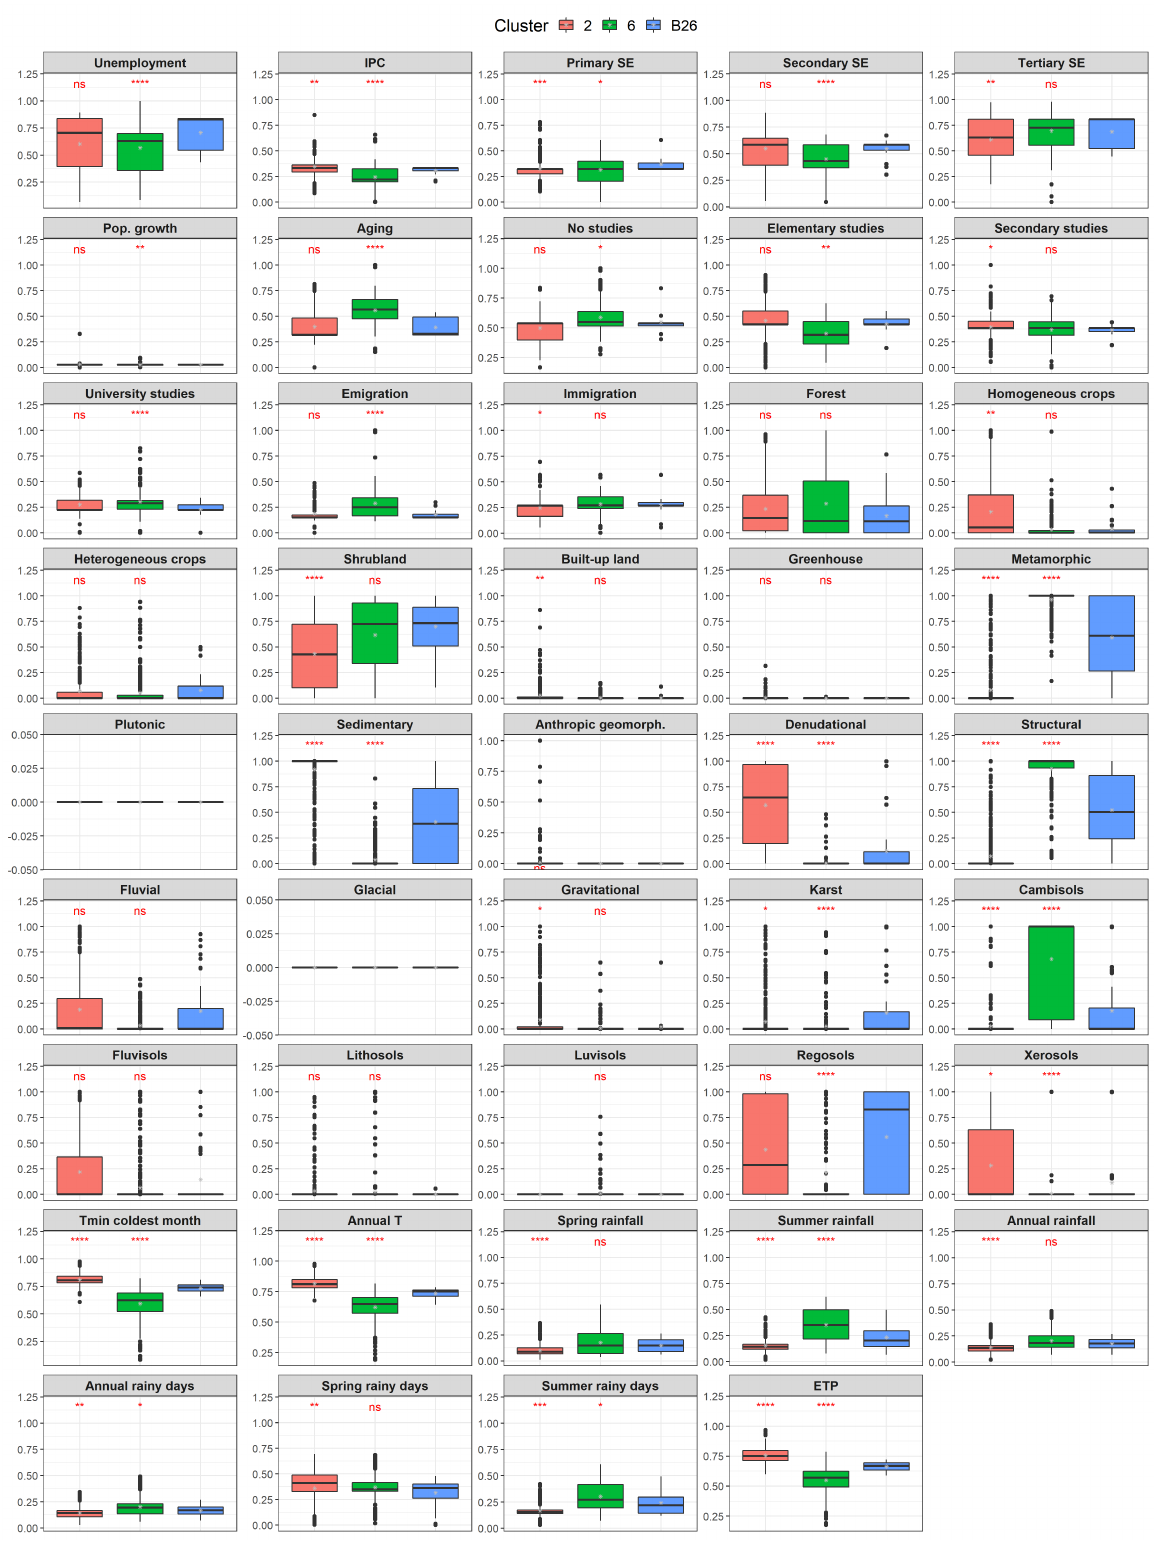
Figure A4. Comparison of the socio-ecological variables between Sectors 2 and 6 and the boundary between them (B26). Statistical significance is shown as: ns: p -value > 0.05; *: p -value ≤ 0.05; **: p -value ≤ 0.01; ***: p -value ≤ 0.001; ****: p -value ≤